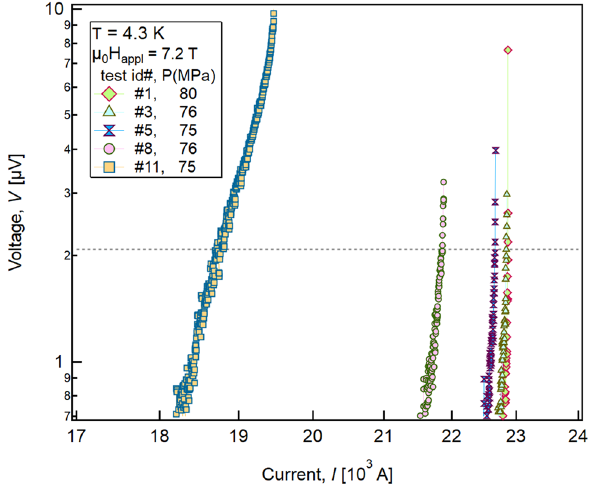
Figure 5. V–I characteristics of the PIT cable at 4.3 K with an applied magnetic field of 7.2 T for the Tests #1, #3, #5, #8 and #11 performed near 80 MPa. The V–I characteristics of tests #1, #3, and #5 are similar to that of Test #8, whereas smoother transitions are observed in the V–I curves of Test